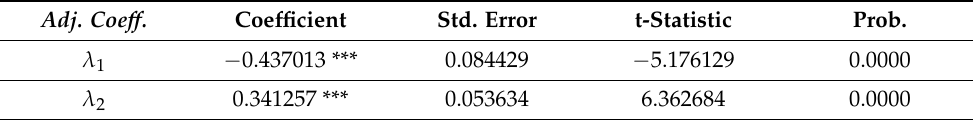
Table 6. VECM 7 adjustment coefficients: period of January 2015–December 2021.